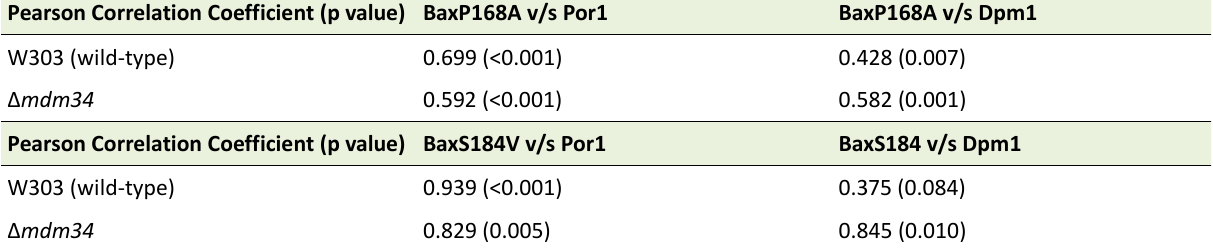
TABLE 1: Co-localization of Bax with Por1 and Dpm1. Pearson Correlation Coefficient (p value) BaxP168A v/s